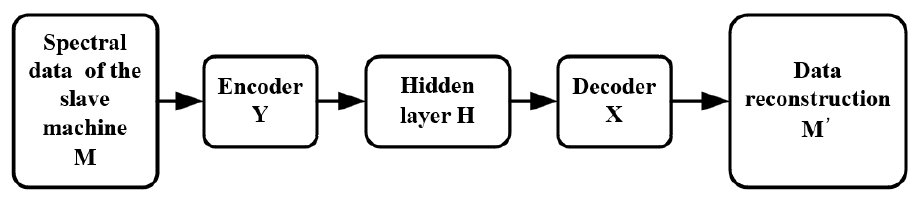
Figure 3. Training process of a model transfer algorithm based on a deep